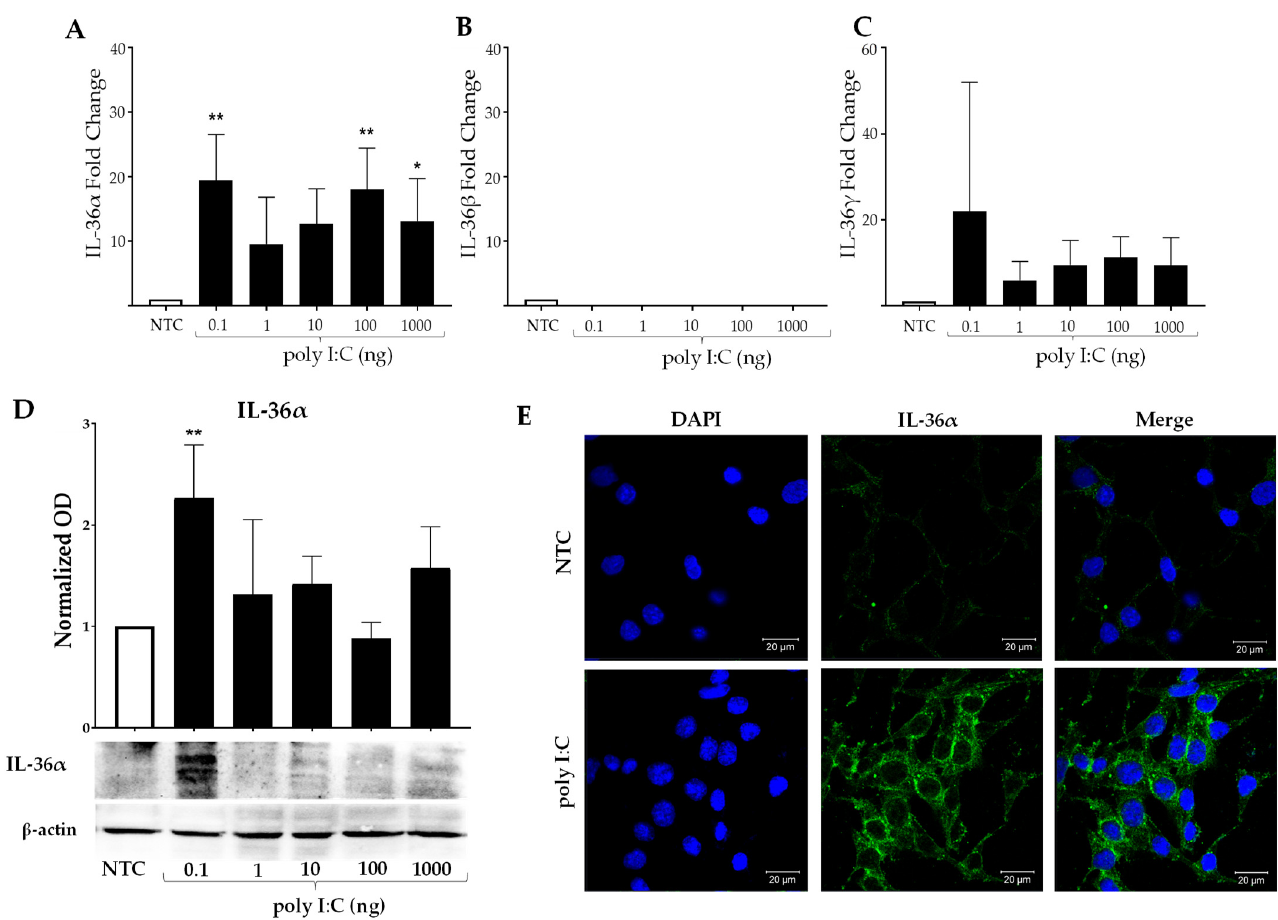
Figure 4. Poly I:C promotes IL-36 α expression in MCs . MES SV40 cells (1.5 × 10 6 ) were stimulated in 2 mL of medium containing different amounts of poly I:C for 2 h, and the expressions of ( A ) IL-36 α ; ( B ) IL-36 β ; ( C ) IL-36 γ were measured. The expression was normalized against Actb, and the fold change was calculated against the non-stimulated control (NTC). ( D ) For the WB analysis, MCs were stimulated for 6 h under similar conditions, and total proteins were extracted. The intensity of bands was normalized against β -actin, and the fold change was calculated. ( E ) Representative IF image of IL-36 α (green stained) in MCs stimulated with 0.1 ng of poly I:C for 6 h. The results were obtained from at least 3 independent experiments and are presented as mean ± SD. Data were analyzed with one-way ANOVA followed by Dunnett´s analysis. * ( p < 0.05), ** ( p < 0.01).